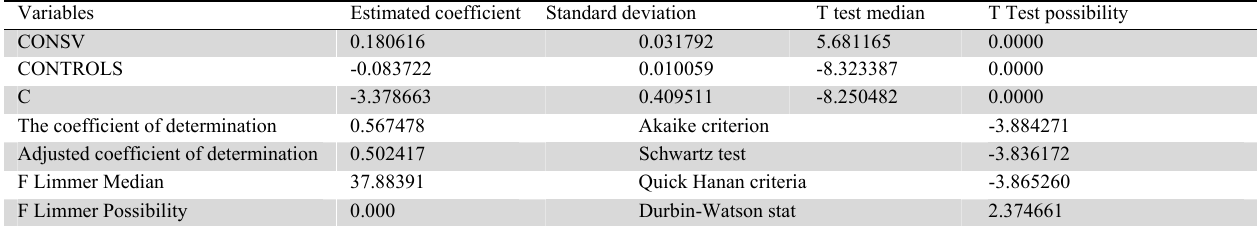
Estimates of the sensitivity of the relationship between investment and conservatism Variables